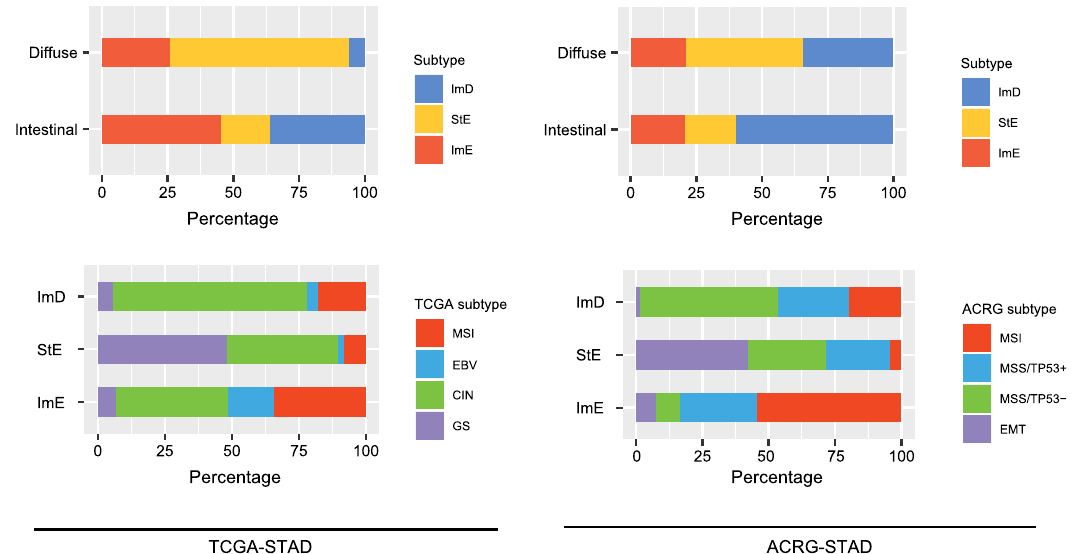
Fig. 9 Comparisons between the pathway-based subtyping and other subtyping methods in GC. Intestinal and Diffuse are histological subtypes based on the pathohistological classi fi cation. The TCGA subtypes identi fi ed by integration of multi-omics data, including somatic mutations, SCNAs, CpG methylation, mRNA, miRNA, and protein expression. The ACRG subtypes identi fi ed based on the gene expression pro fi les of EMT, MSI, and TP53 signatures. Intestinal is enriched with ImD and ImE, and Diffuse is dominated by StE. ImD contains CIN, StE contains GS and EMT, and ImE contains MSI and EBV-associated GCs, respectively. Chi-square test, P < 0.001.